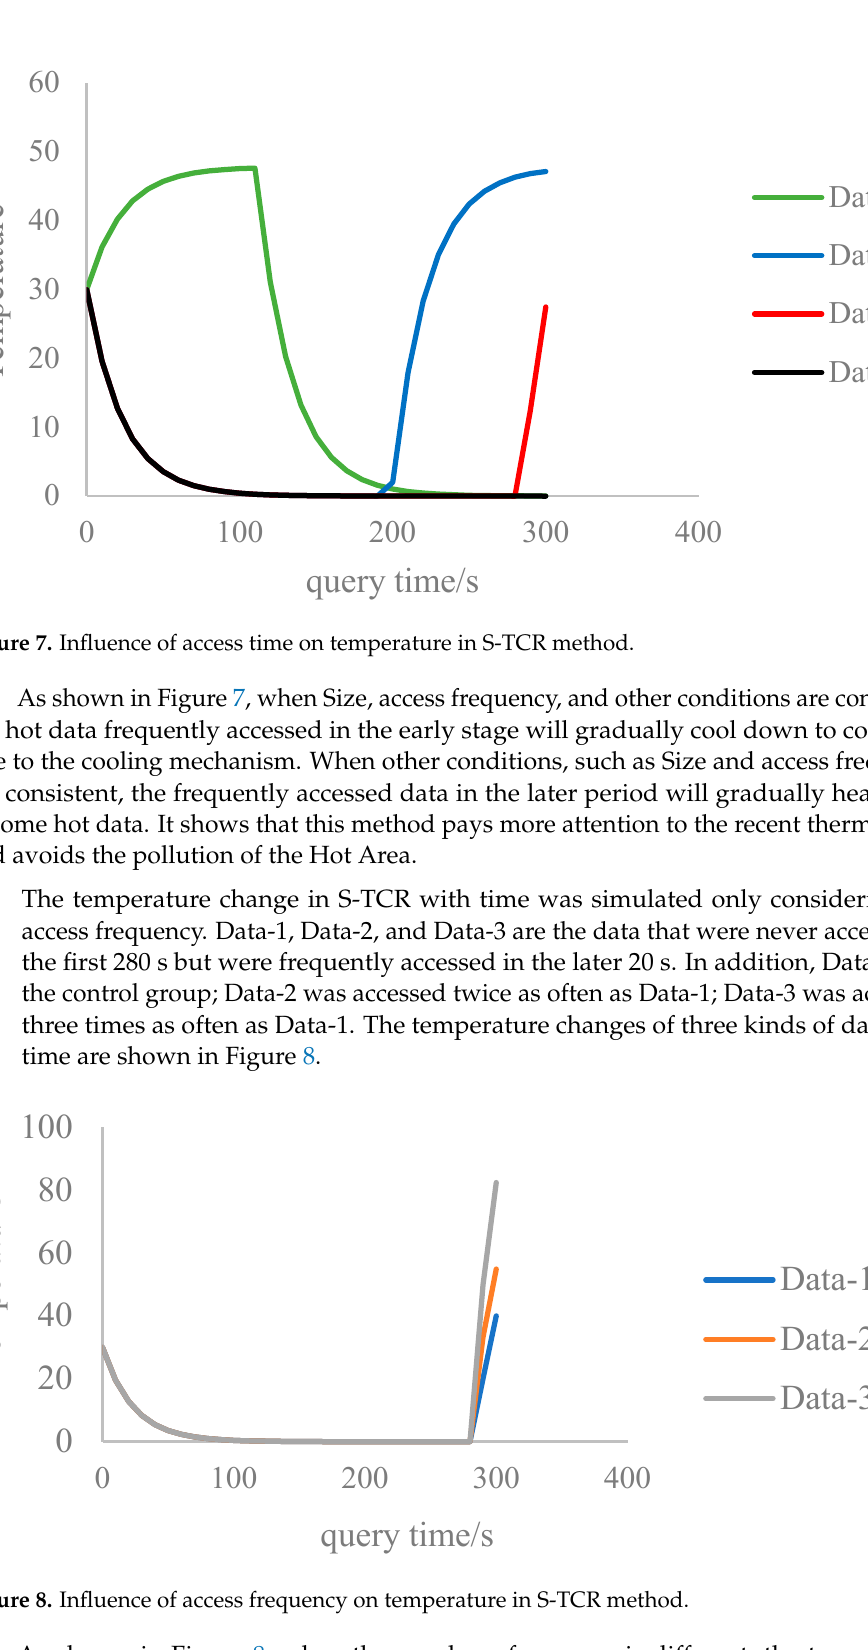
Figure 8. Influence of access frequency on temperature in S-TCR method.